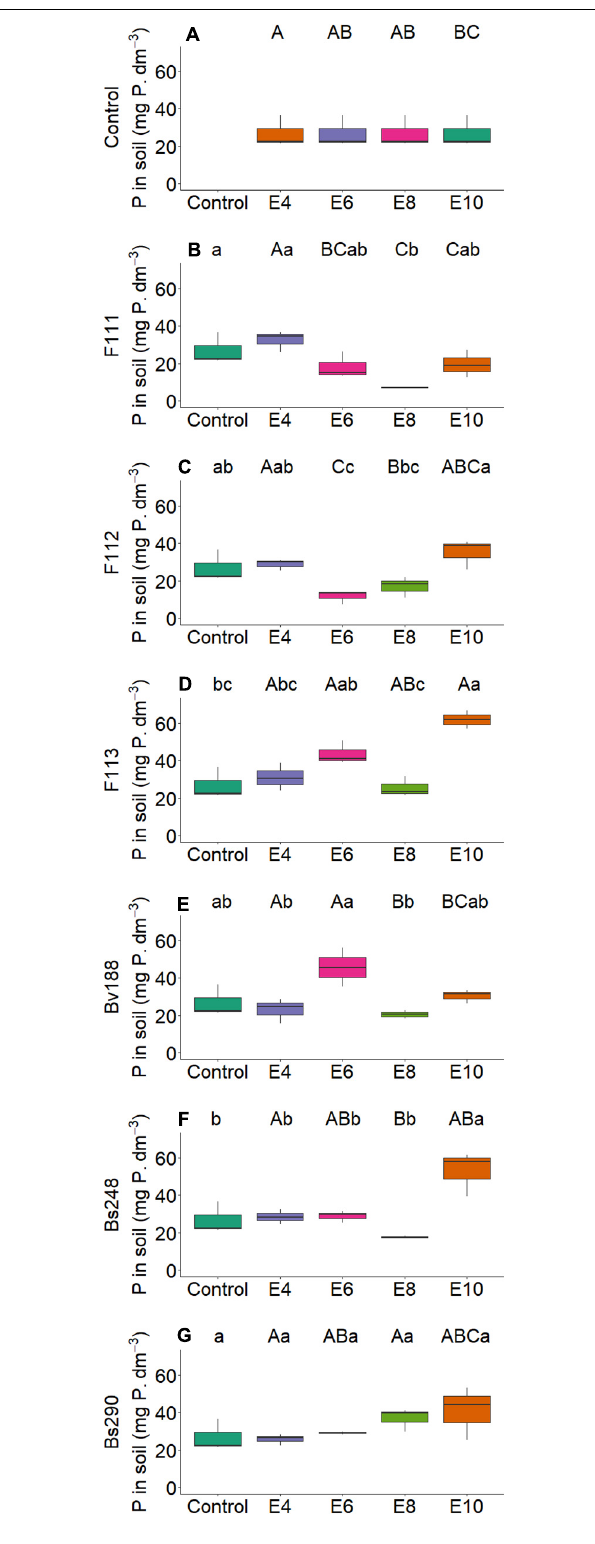
FIGURE 4 | Boxplots (median and quartiles) of phosphorus in soil sown with cotton and inoculated with plant growth-promoting